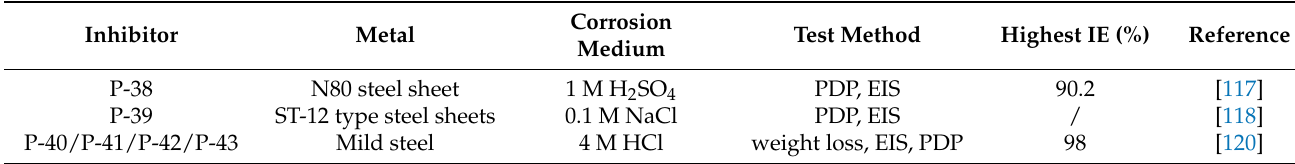
Table 5. Inhibition property of other types of polymeric inhibitor.